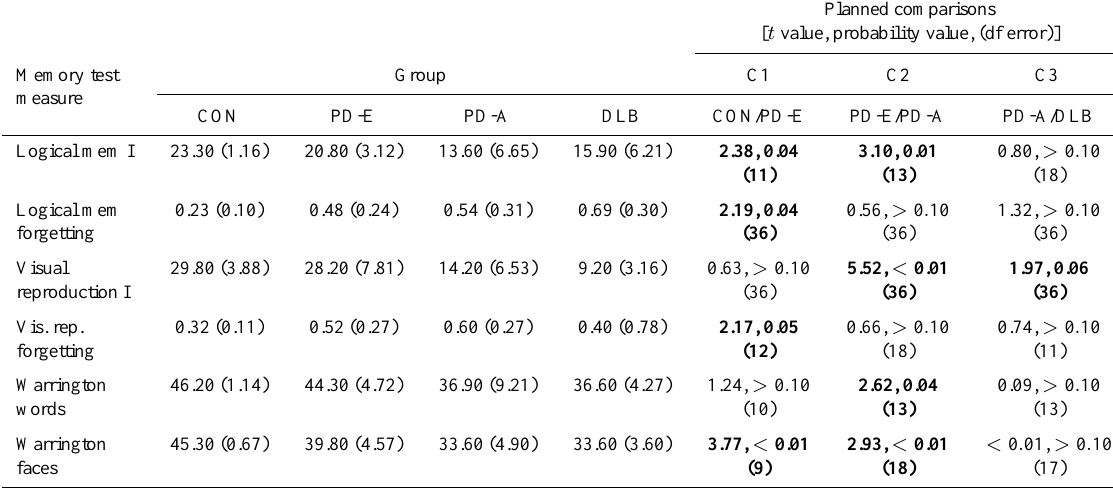
Means, standard deviations, and planned comparisons for the memory test measures